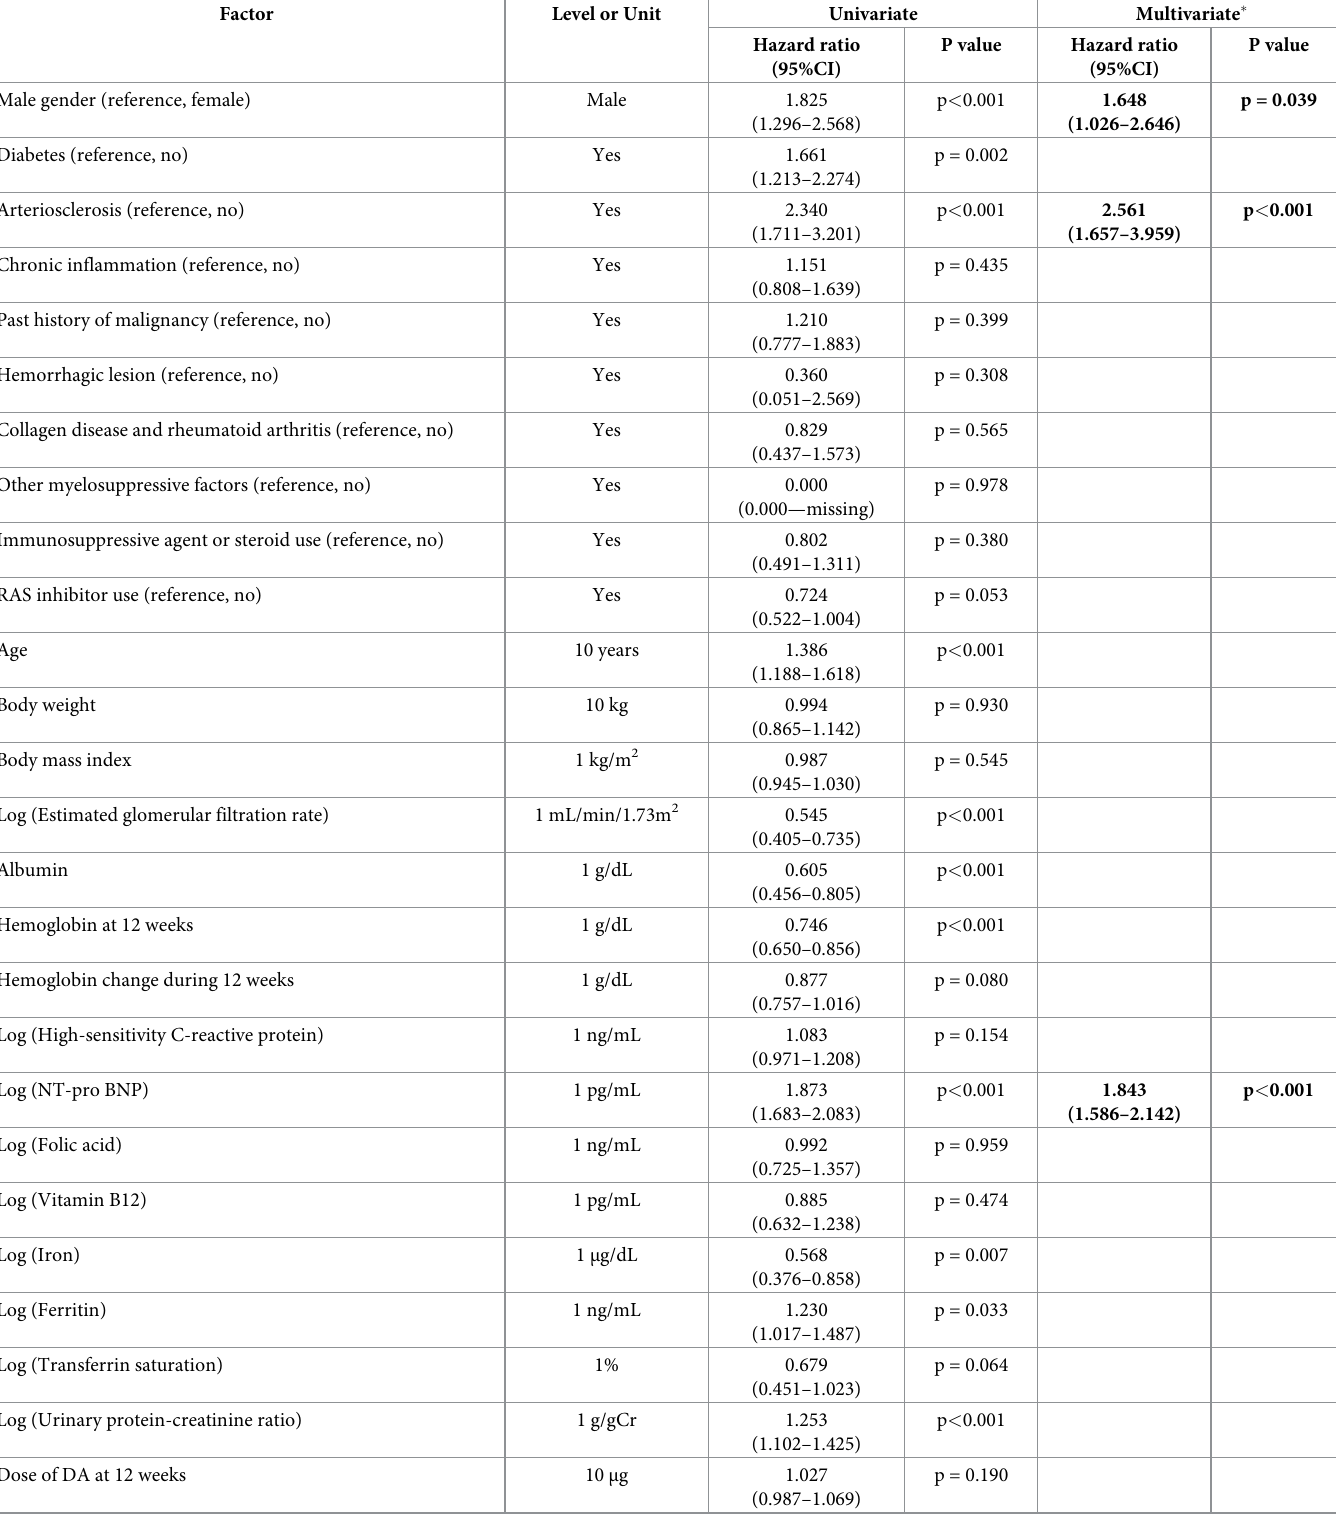
Table 3. Cox proportional hazards model analysis for cardiovascular disease